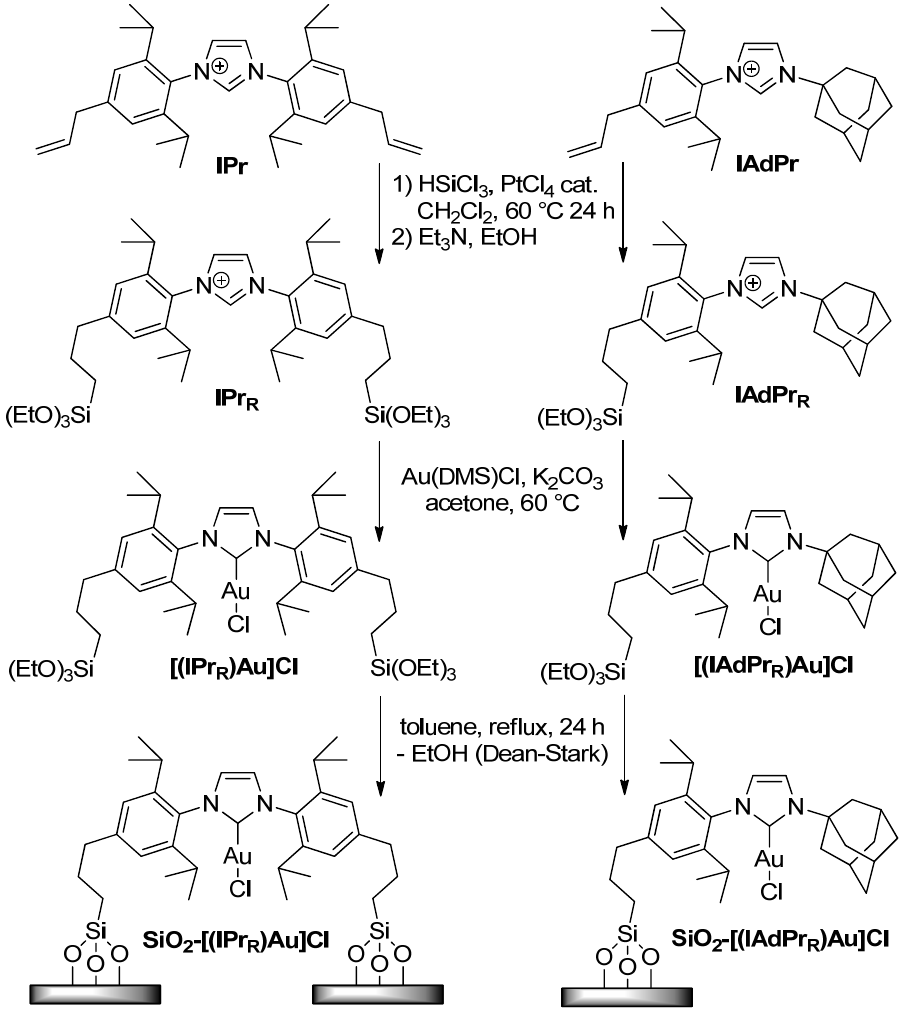
Scheme 66. Schematic route for the immobilization of Au(I) complexes [(IPr R )Au]Cl and [(IAdPr R